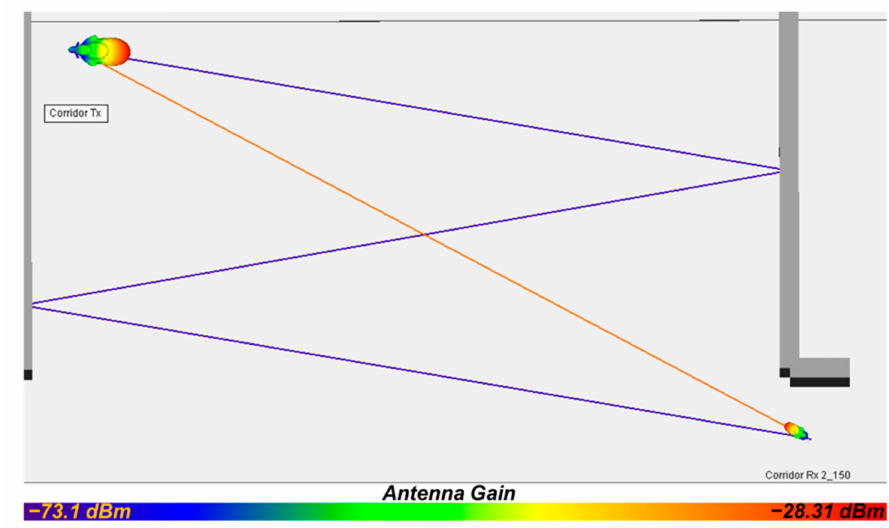
Figure 11. LOS and two reflected ray propagation paths from the transmitter to Rx2_150°.